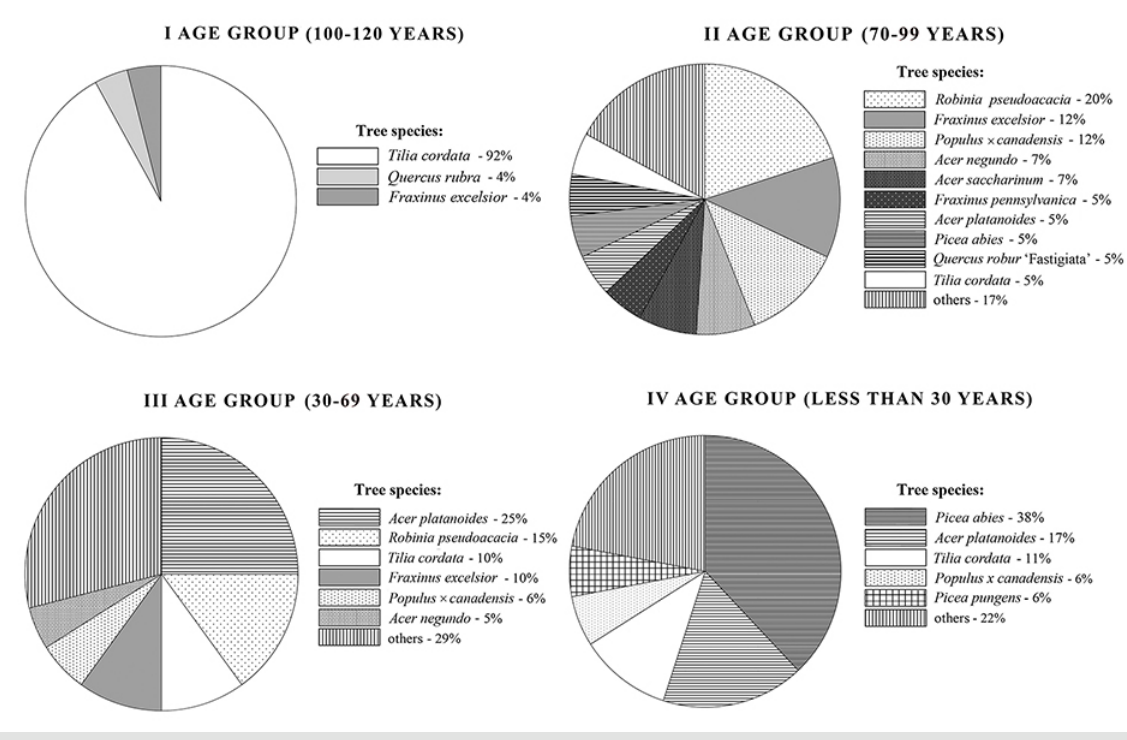
Fig. 5 Percentage share of trees in the age groups in Felin Manor Park, Poland in 2016